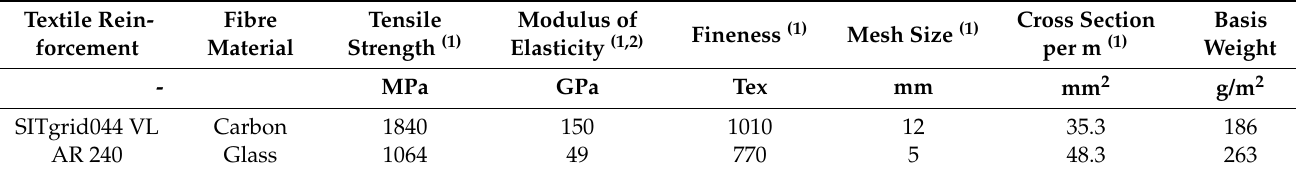
Figure 2. ( a ) Carbon textile SITgrid044 VL; ( b ) glass textile AR 240. The properties of the textiles used are shown in Table 2. Table 2. Material properties of SITgrid044 VL according to